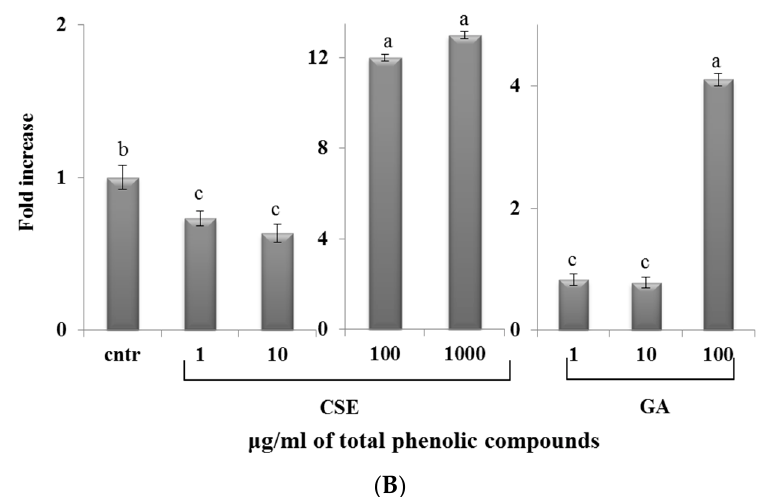
Figure 6. Percentage of the phagocytosis of zymosan A fluorescein conjugate by intestinal intraepithelial non-adherent leukocytes ( A ) and blood non-adherent leukocytes ( B ) of rainbow trout in response to different doses of CSE and GA in in vitro incubations. The data represent the mean ± SD of different fish samples ( n = 9). Different letters on the columns indicate statistically significant differences (cntr = control). The concentration reported on the x axis refers to the total phenolic compounds contained in the chestnut shell extract (CSE).